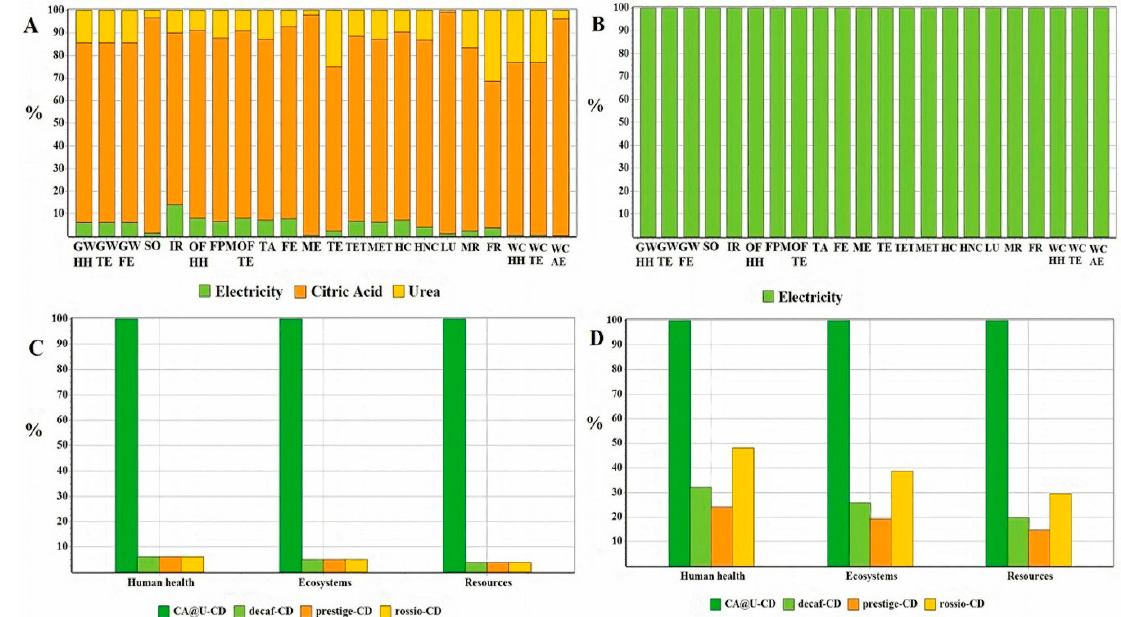
Figure 5. Relative environmental impacts of CA@U-CDs ( A ) and of spent coffee grounds (SCG)-based CDs ( B ) with the ReCiPe2016 as the life cycle impact assessment (LCIA) method. Comparative environmental ( C , D ) profiles for the four different routes for the synthesis of CDs. Environmental profiles were obtained using ReCiPe2016 as LCIA. Graphic C refers to an analysis using a weight-based functional unit of 1 kg of CDs, while Graphic D is re-scaled with respect to the QY FL of the CDs.